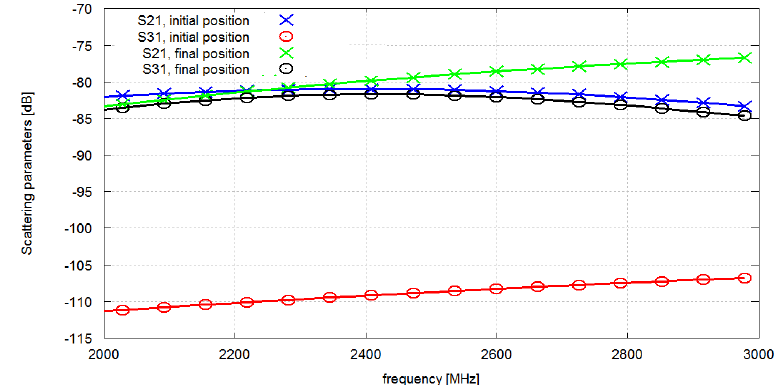
Figure 9. Scattering matrix parameter values vs. frequency before and after optimization for 2.4 GHz frequency band.